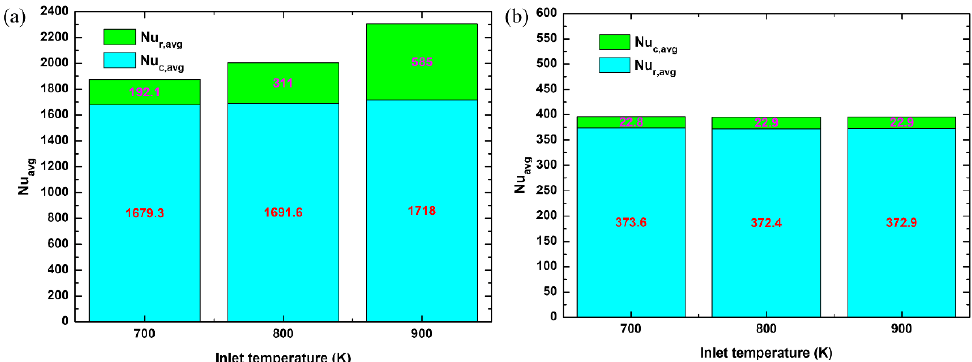
Figure 13. The change of the Nusselt number with different cooling air temperatures for ( a ) wall_1; ( b ) wall_2.